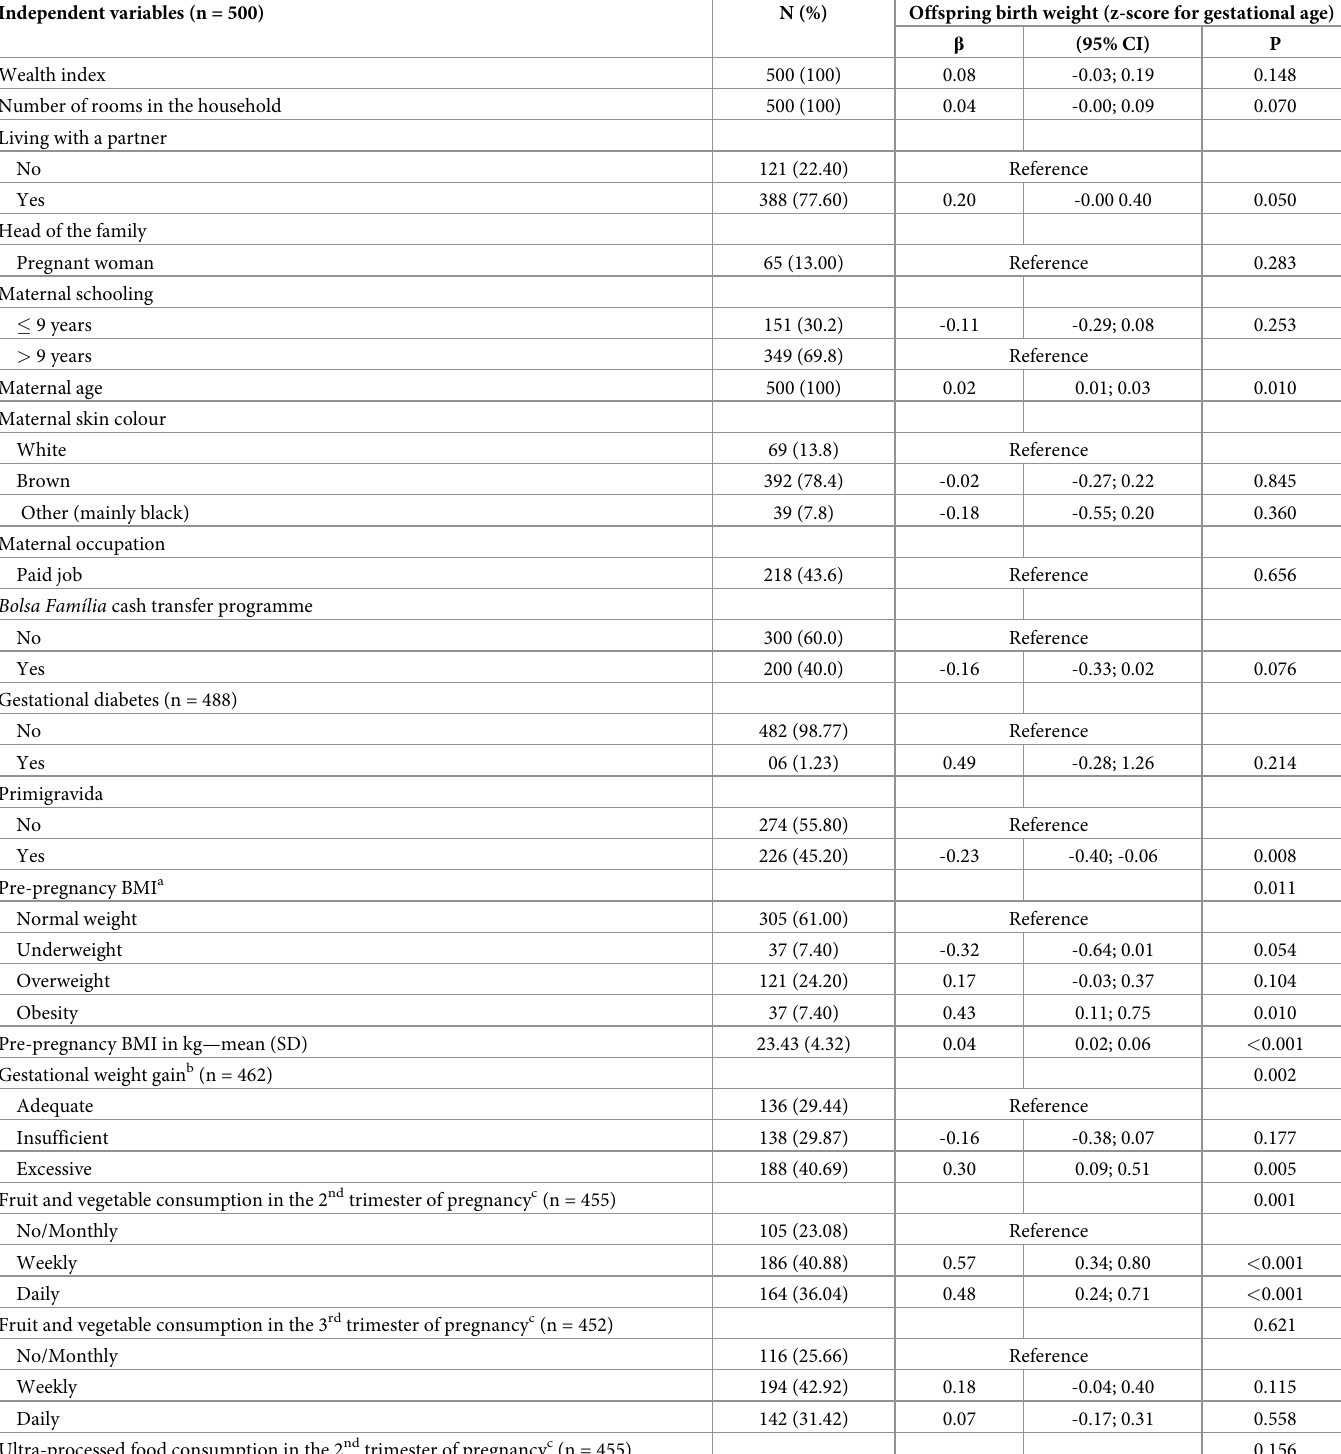
Table 1. Characteristics of pregnant women at baseline and factors associated with the offspring birth weight z-score for gestational age in the MINA-Brazil birth cohort